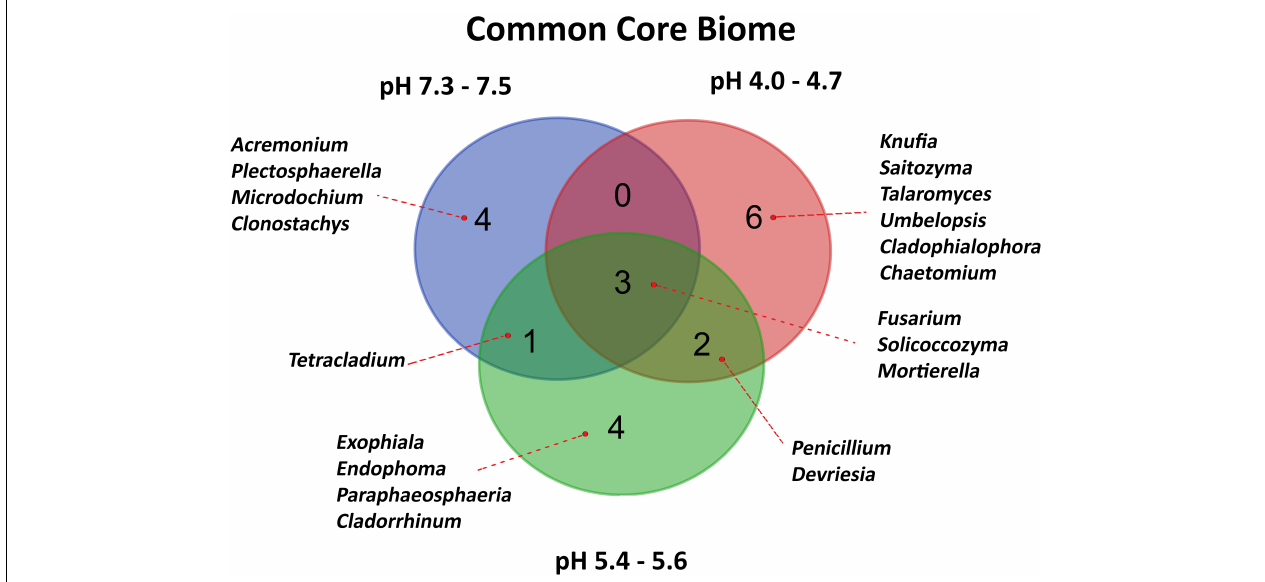
FIGURE 5 | Venn diagram representing Common Core Biome of fungal communities characteristic of different soil pH groups. Fungal 20 representatives were selected, assuming minimum abundance equal to 1% and the presence in all soils of a pH